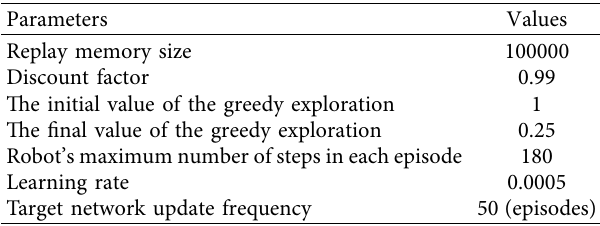
Figure 4: The schematic diagram of state input. Table 2: The list of parameters of